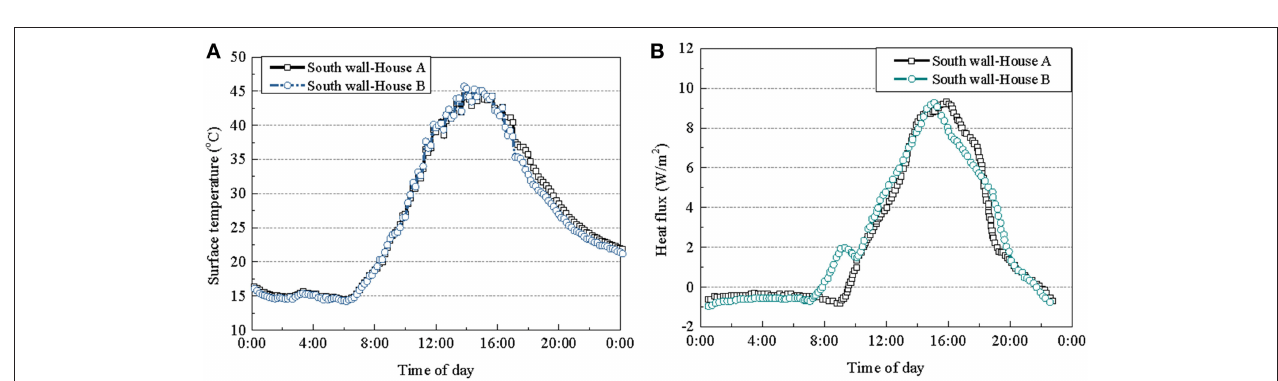
FIGURE 3 | Experimental results on the south-facing walls before retrofit (June 23). (A) Outside surface temperatures. (B) Wall heat flux.